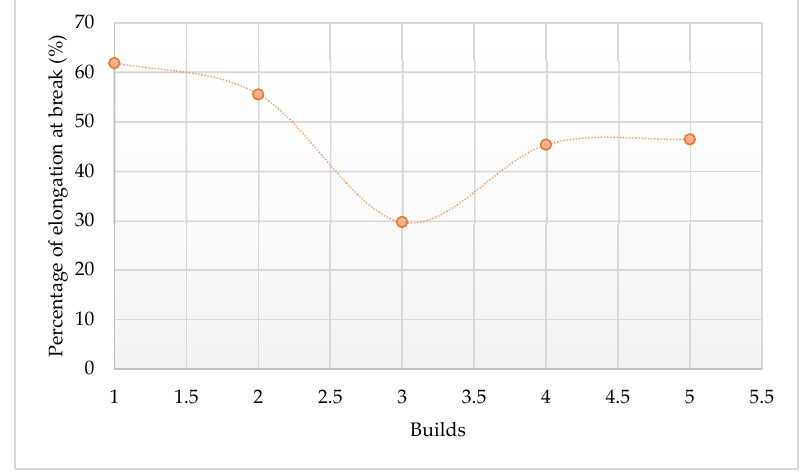
Figure 18. Young’s modulus of parts printed using Laser PP CP 75. The Young’s modulus of the printed parts decreases continuously with the re ‐ using of the powder up to the 2nd re ‐ use cycle from an initial value of 1141.273 MPa for the 1st print cycle to 807.638 MPa after the 3rd print cycle. After this, Young’s modulus starts to Figure 19. Percentage elongation at break of Laser PP CP 75 printed parts. increase with each re ‐ use cycle. Figure 19. Percentage elongation at break of Laser PP CP 75 printed The percentage elongation of the printed parts decreases continuously with the re ‐ use of powder up to the 2nd re ‐ use cycle, starting with 61.91% for parts printed with virgin powder to 29.73% after the 3rd print cycle. After the 2nd re ‐ use cycle, the percentage elon ‐ gation increases for the next re ‐ use cycle and then levels out beyond this. The trends seen in the curves of the variation of the strength, stiffness, and percentage elongation of printed parts might be due to changes in the crystallinity of the material (see Figure 14). This is due to the entanglement and ordered chain folding of the long carbon chains during the L ‐ PBF process, which rise and drop with increased crystallinity, respec ‐ tively [25]. Therefore, increased crystallinity will raise the ultimate tensile strength of printed parts at the expense of reduced stiffness and percentage elongation to break [12]. It can be seen from the preceding figures that Laser PP CP 75 attained the highest ultimate tensile strengths in the 2nd re ‐ use cycle. Another study by Wegner & Ünlü [20] concluded that the mechanical characteristics of parts produced using PP reduce with the number of re ‐ use cycles (Figure 20). The re ‐ duction in mechanical properties is subject to the energy density of the laser beam used.